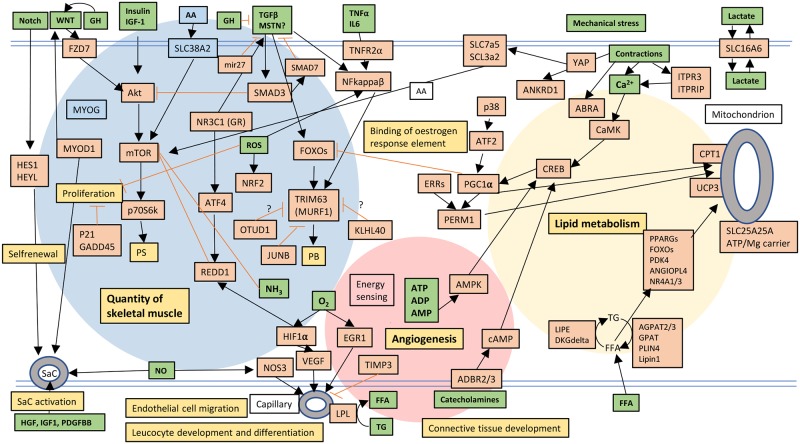
Simplified overview of molecular signalling after sprint exercise.A selection of stimuli (green–increased and blue—decreased), signalling pathways (red–upregulated and blue–downregulated and downstream biofunctions (yellow) are presented. The selection is based on skeletal muscle mRNA levels (microarray), predicted upstream regulators (IPA-analysis), predicted downstream biofunctions (IPA-analysis), protein phosphorylations (Western blot) and blood data (substrates and hormones) from the present study and earlier publications from the same experimental set up [2, 16]. AMPK activation after sprint exercise was shown by Gibala et al 2009 [7] and inhibition of mTOR by ammonia (NH3) was shown by Kumar et al [17] in vitro. Observe that it is not possible, in this figure, to differentiate between how the various pathways are activated, e.g. phosphorylations, transcriptional activation etc.) Three major areas are highlighted: regulation of muscle mass, lipid/energy metabolism and angiogenesis. For details and explanations see Results and Discussion. PS = protein synthesis, PB = protein breakdown, ROS = reactive oxygen species.